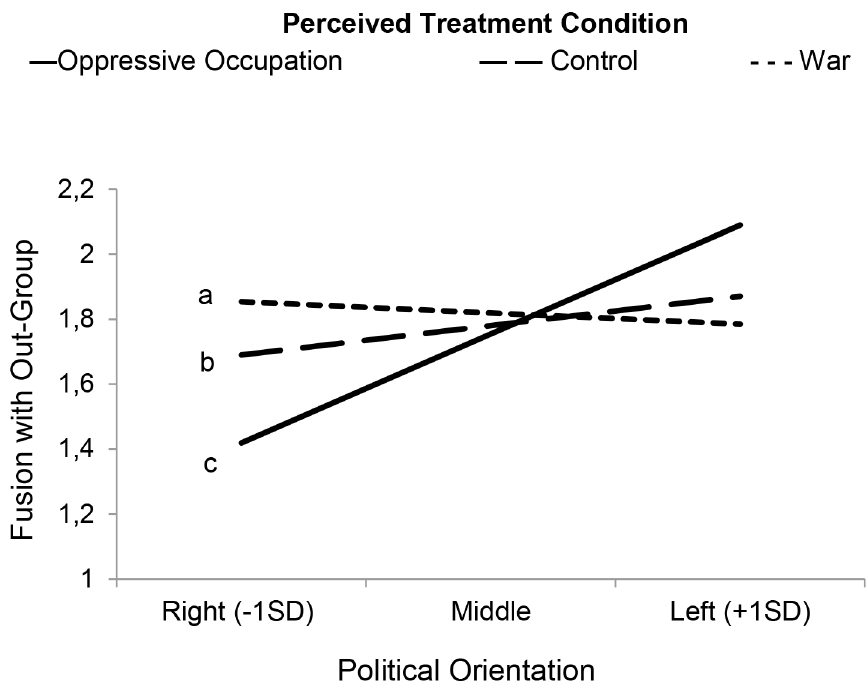
Fig 4. In Study 3, Leftist political orientation predicted more fusion with the Kurdish out-group when they were described as being victims of oppressive occupation but was unrelated to fusion with the out-group in the control and war condition. a B = -.01, SE = .04, p = .760, 95% CI [-.10, .07]; b B = .03, SE = .05, p = .531, 95% CI [-.07, .14]; c B = .13, SE = .05, p = .014, 95% CI [.03, .23].